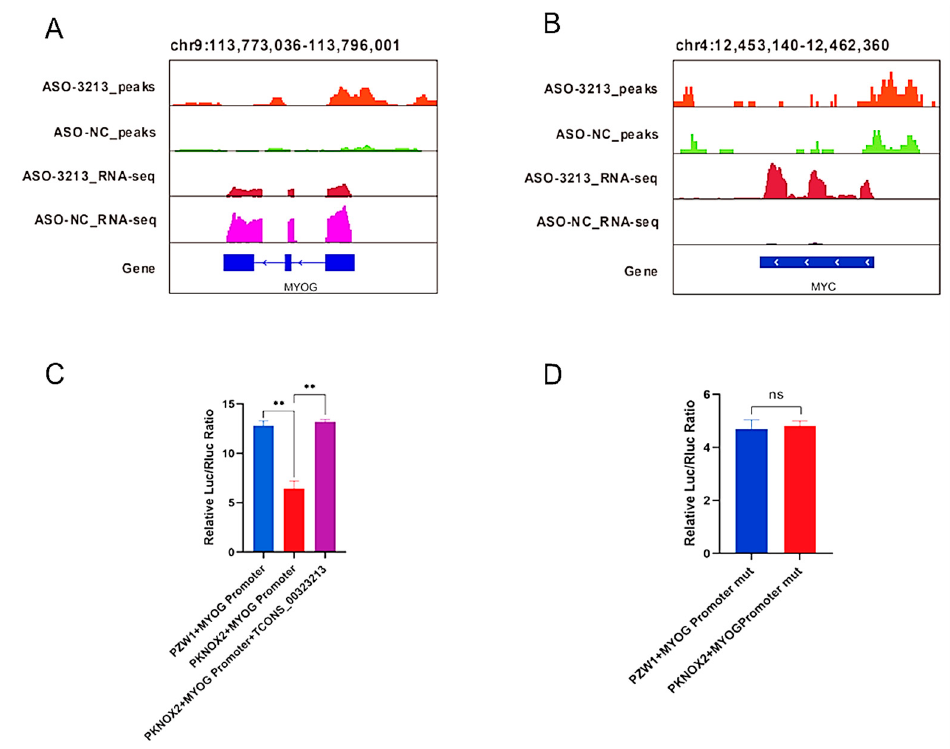
Figure 6. IGV visualization demonstrates the RNA-seq and CUT and Tag signatures of myogenic differentiation-related genes. ( A ) Enrichment signal of PKNOX2 on MyoG and differential expression of MyoG by RNA-Seq. ( B ) The enrichment signal of PKNOX2 on MYC and differential expression of MYC by RNA-Seq. ( C ) PKNOX2 overexpression reduced the luciferase activity of the wild-type MyoG promoter construct, and luciferase activity increased upon TCONS_00323213 overexpression after PKNOX2 and the MyoG promoter plasmid had been co-transfected with the MyoG promoter. ( D ) Overexpression of PKNOX2 does not affect the luciferase activity of the MyoG promoter mutant. Mean values ± SD, n = 3. ** p < 0.01. ns indicates no significant difference.